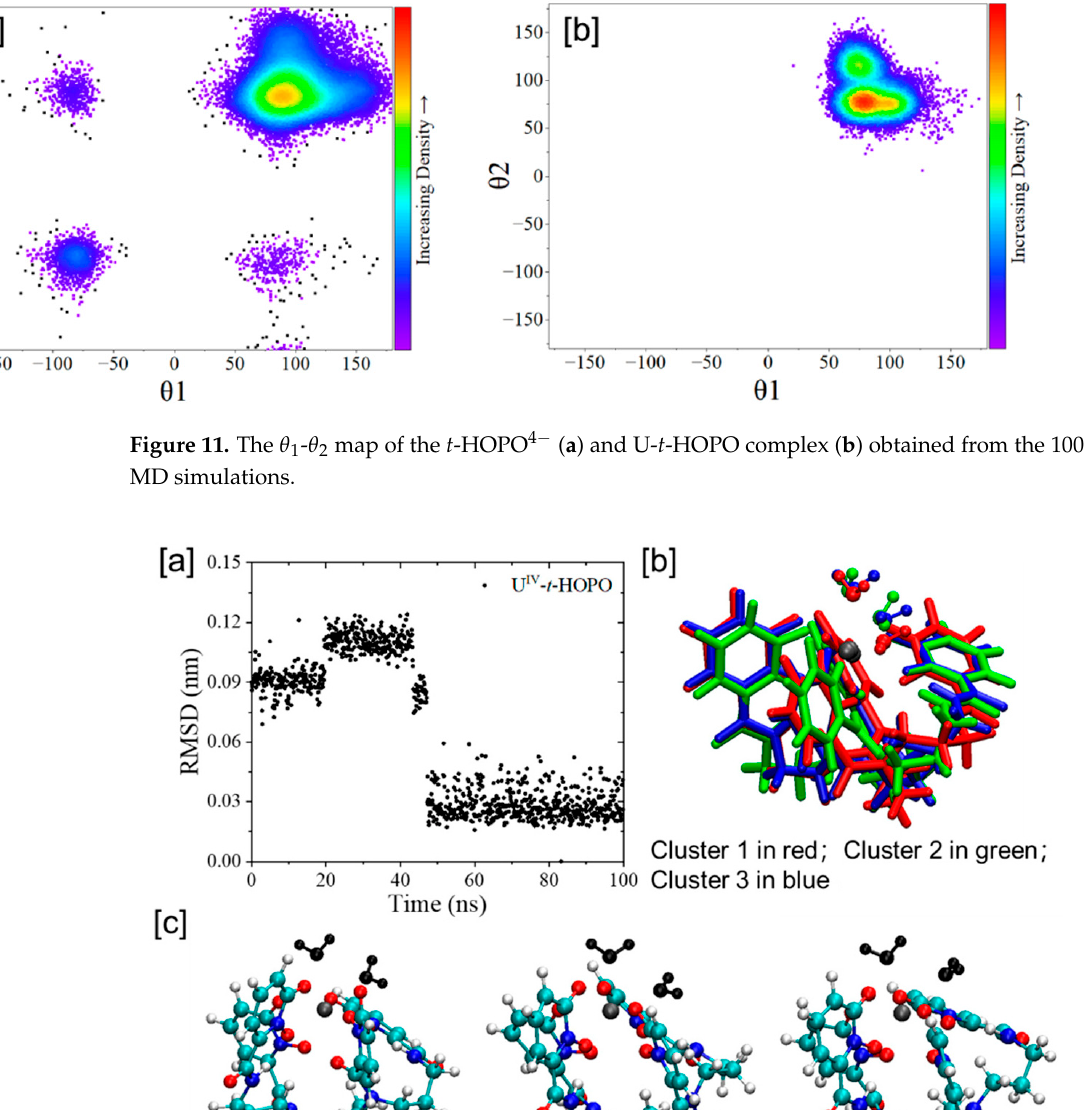
Figure 10. ( a ) The radius of gyration (Rg) and ( b ) eccentricity ( ε ) of t -HOPO 4 − and U IV - t -HOPO com- plex.